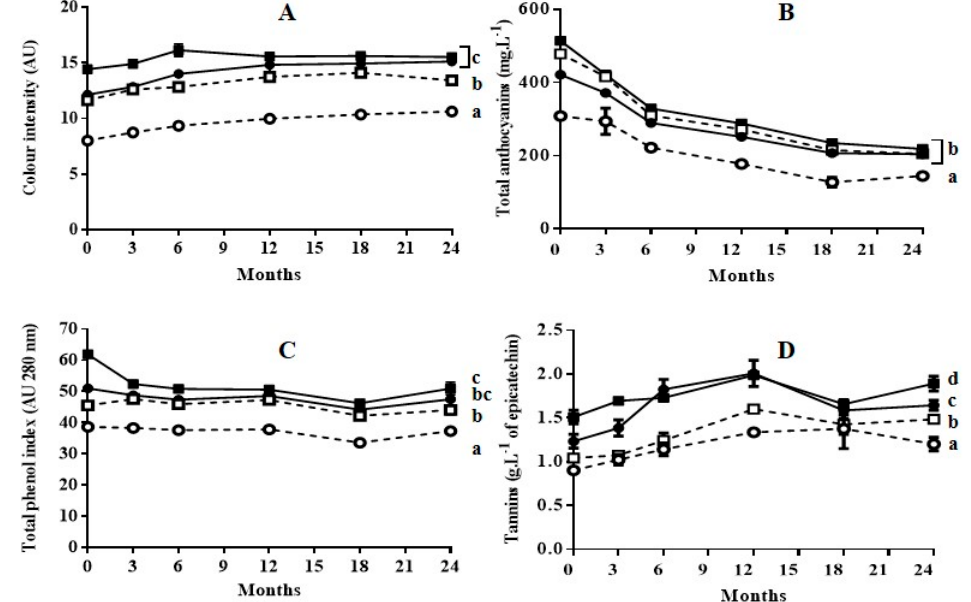
Figure 2. Evolution of color intensity ( A ), total anthocyanins ( B ), total phenol index ( C ), and tannins ( D ) of wines during 24 months of aging in bottles. ( ○ ) wine obtained from untreated grapes with 3 days of maceration; ( ● ): wine obtained from PEF-treated grapes with 3 days of maceration; ( □ ): wine obtained from untreated grapes with 6 days of maceration; ( ■ ): wine obtained from PEF-treated grapes with 6 day of maceration. Different letters represent significant differences according to one-way ANOVA analysis ( p < 0.05).